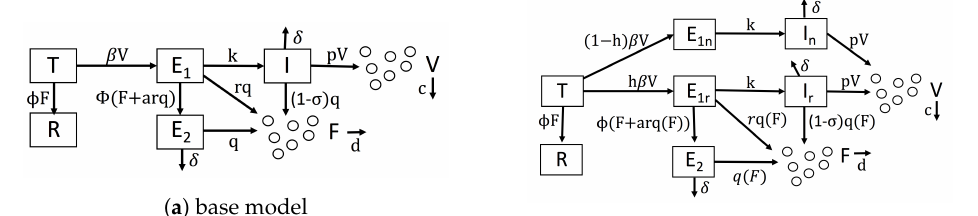
Figure 1. Diagrams of our mathematical models. ( a ) Our base model, which is similar to Saenz et al.’s model. ( b ) Our extended model, which accounts for IFN feedback and heterogeneity. IFN feedback is modeled through the function q ( F ) , which gives the secretion rate as a function of extracellular IFN concentration. Heterogeneity is modeled through the parameter h , which gives the fraction of target cells capable of inducing